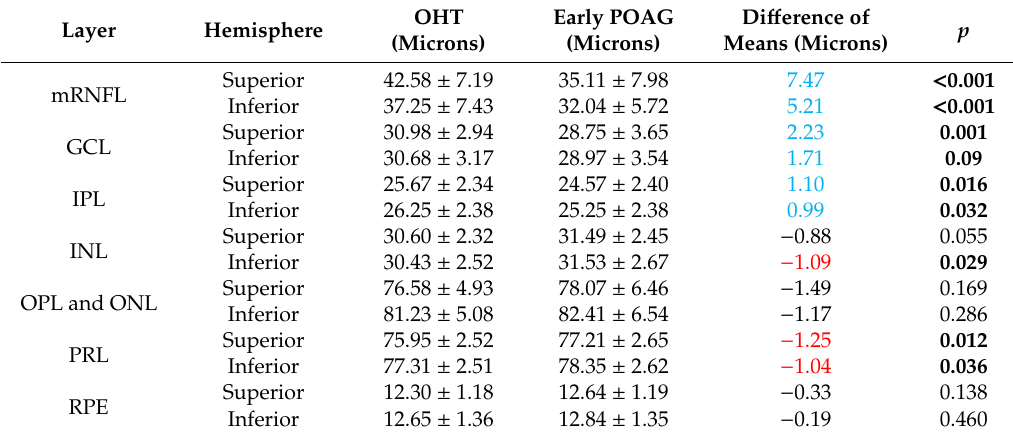
Table 2. Comparisons of mean thickness of superior and inferior hemispheres between OHT and early POAG